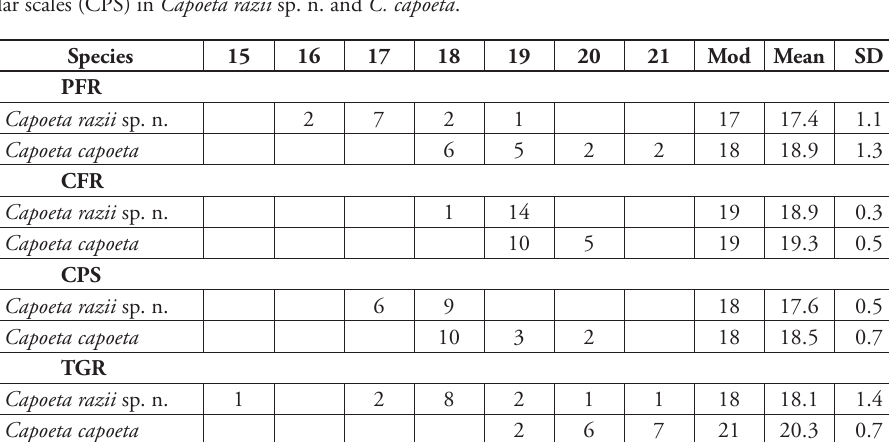
Table 5. Number of scales above lateral line (ALL), below lateral line (BLL), Number Dorsal Soft Rays (DSR)/Hard (DHR), Anal Soft Rays (ASR)/Anal Hard Rays (AHR), pelvic (PLR) fin rays and Number Gill rakers on the lower limb (LOL) in Capoeta razii sp. n. and C. capoeta . Species 3 SD ALL Capoeta razii sp. n. Capoeta capoeta BLL Capoeta razii sp. n. Capoeta capoeta DHR Capoeta razii sp. n. 1 Capoeta capoeta DSR Capoeta razii sp. n. Capoeta capoeta AHR Capoeta razii sp. n. Capoeta capoeta ASR Capoeta razii sp. n. Capoeta capoeta PLR Capoeta razii sp. n. LOL Capoeta razii sp. n. Capoeta capoeta